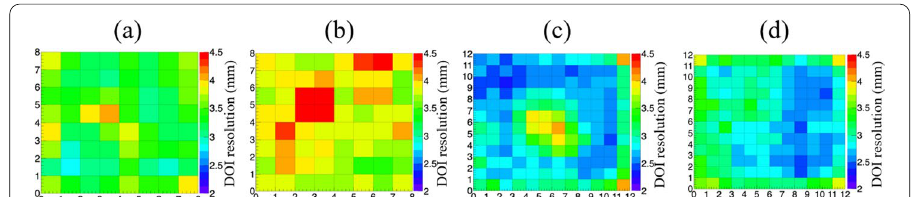
Fig. 10 DOI resolutions of all individual crystals in a detector 1, b detector 2, c detector 3, and d detector 4